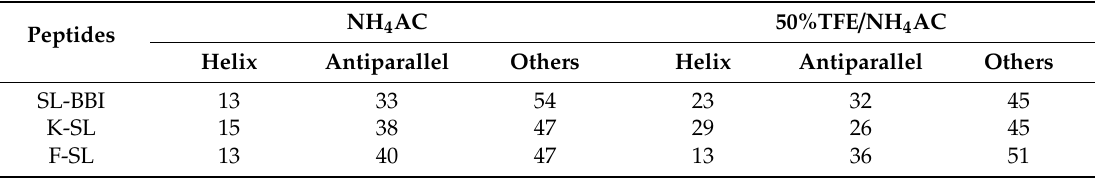
Figure 3. Circular dichroism spectra of SL-BBI (coloured red), K-SL (coloured green) and F-SL (coloured blue) (100 µ M) in aqueous ammonium acetate bu ff er and membrane mimic 50% TFE / 10 mM ammonium acetate bu ff er. Table 2. The proportion of di ff erent secondary structures domain (%) was predicted by using the online software, BeStSel (Beta Structure